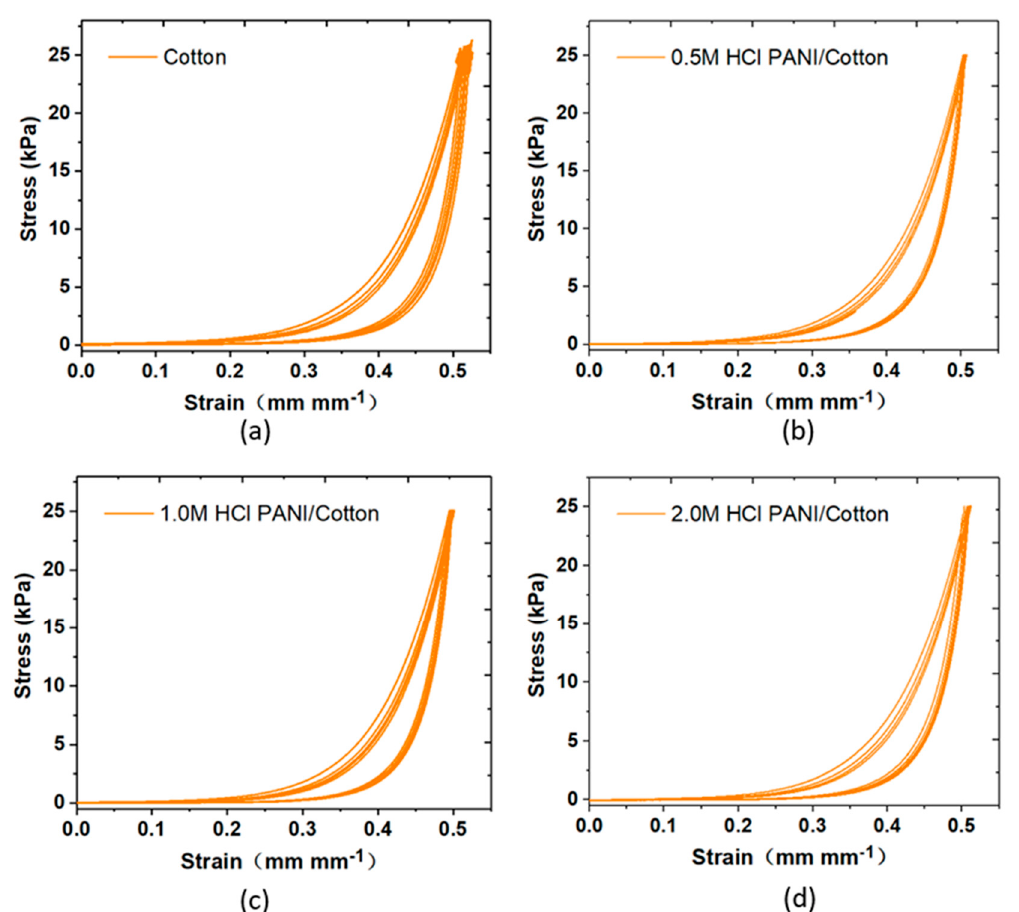
Figure 4. Consecutive compression tests on the PANI-coated nonwoven fabric. ( a ) Cotton, ( b ) 0.5 M HCl PANI / cotton, ( c ) 1.0 M HCl PANI / cotton, and ( d ) 2.0 M HCL PANI / cotton.